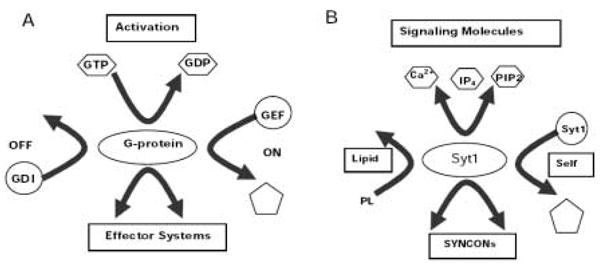
The cycle of activation and inactivation of proteins that drive a cellular process (A) the associated regulators of heterotrimeric G-proteins (B) the cycle of synaptotagmin (Syt) according to interaction with signalling molecules, phospholipids (PL), additional SYNCONs and its self oligomerization (Self). For details see text.